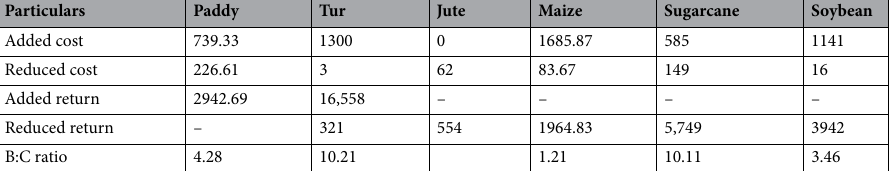
Table 8. Economic feasibility of NCU use for reference crops (partial budgeting framework) (Rs/acre). Source: Authors’ estimates using field survey data.